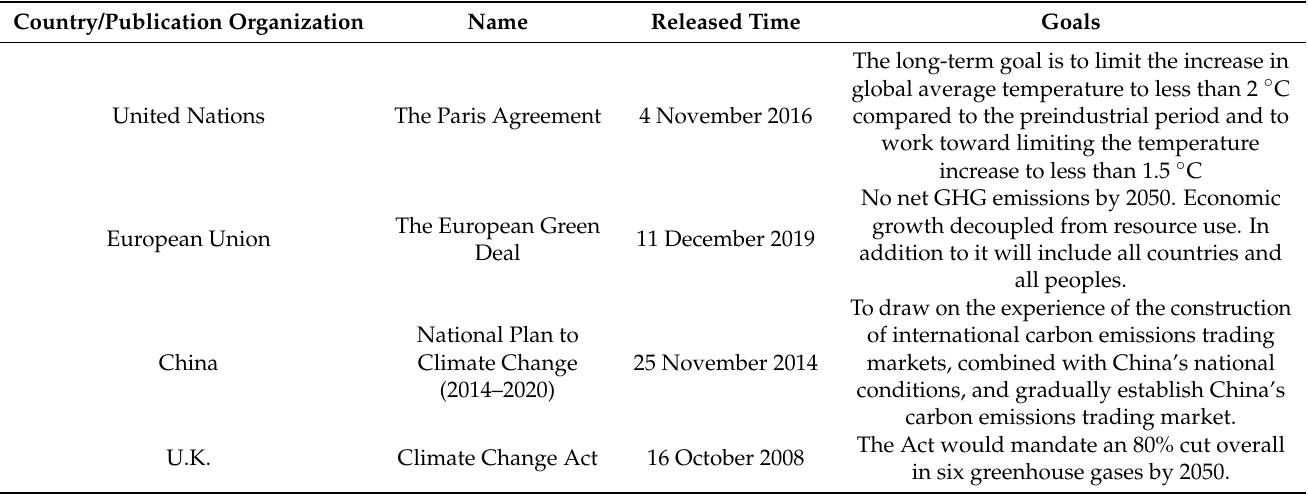
Table 1. Policies of climate change in different